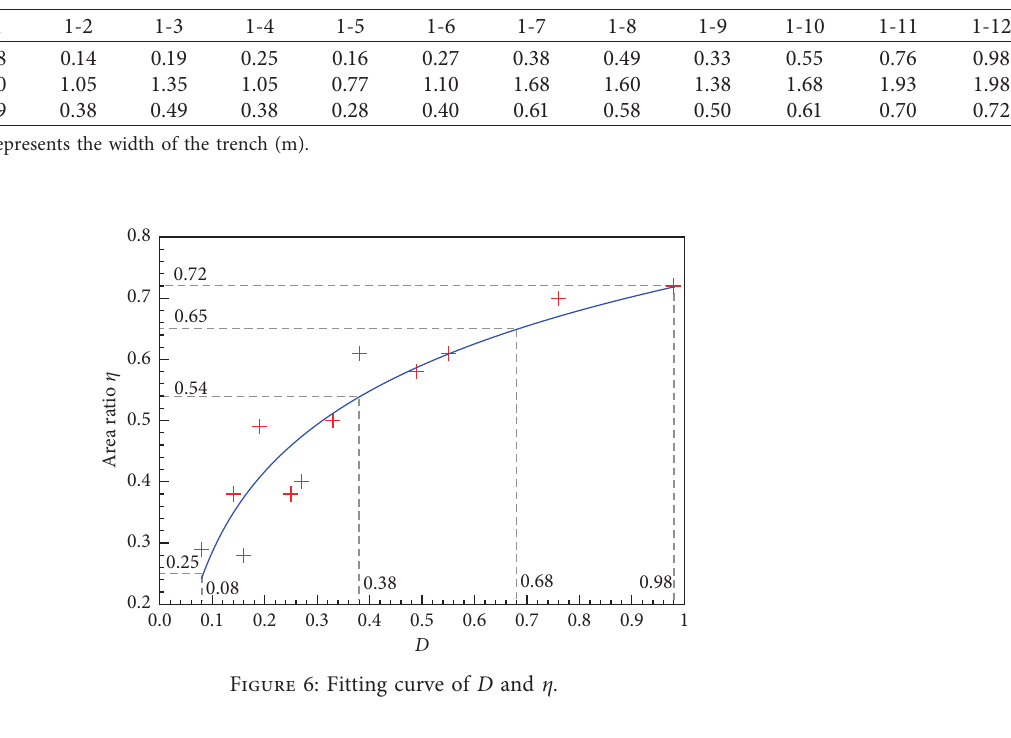
Table 5: List of vibration isolation areas.